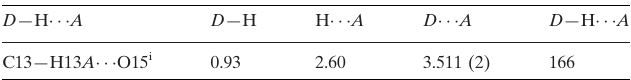
Hydrogen-bond geometry (A˚ , (cid:2)